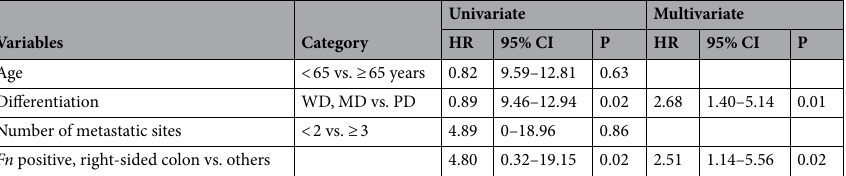
Table 2. Univariate and multivariate analyses of progression-free survival (PFS)1 in the first-line treatment. WD well differentiated; MD moderately differentiated; PD poorly differentiated; PFS1 progression-free survival1; Fn , Fusobacterium nucleatum ; HR hazard ratio, CI confidence interval.